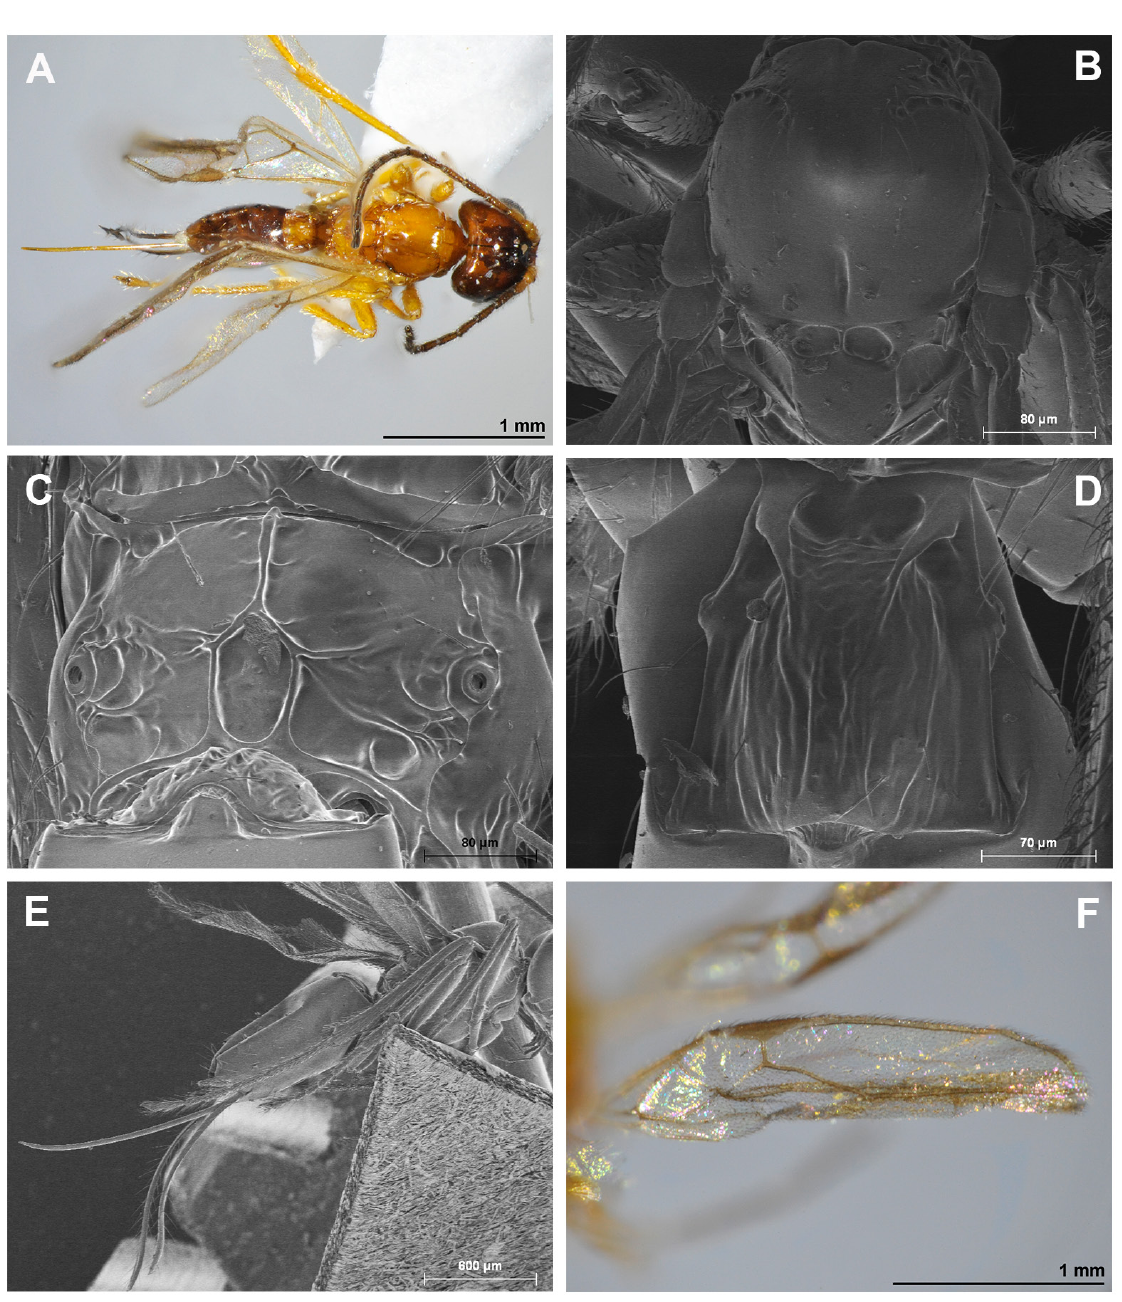
Fig. 53. Asobara rufimalawiana Fischer, 2007, ♀, holotype (OLML). A . Habitus, dorsal view. B . Mesoscutum, dorsal view. C . Propodeum, dorsal view. D . First metasomal tergite, dorsal view. E . Hind leg, metasoma and ovipositor, lateral view. F . Fore